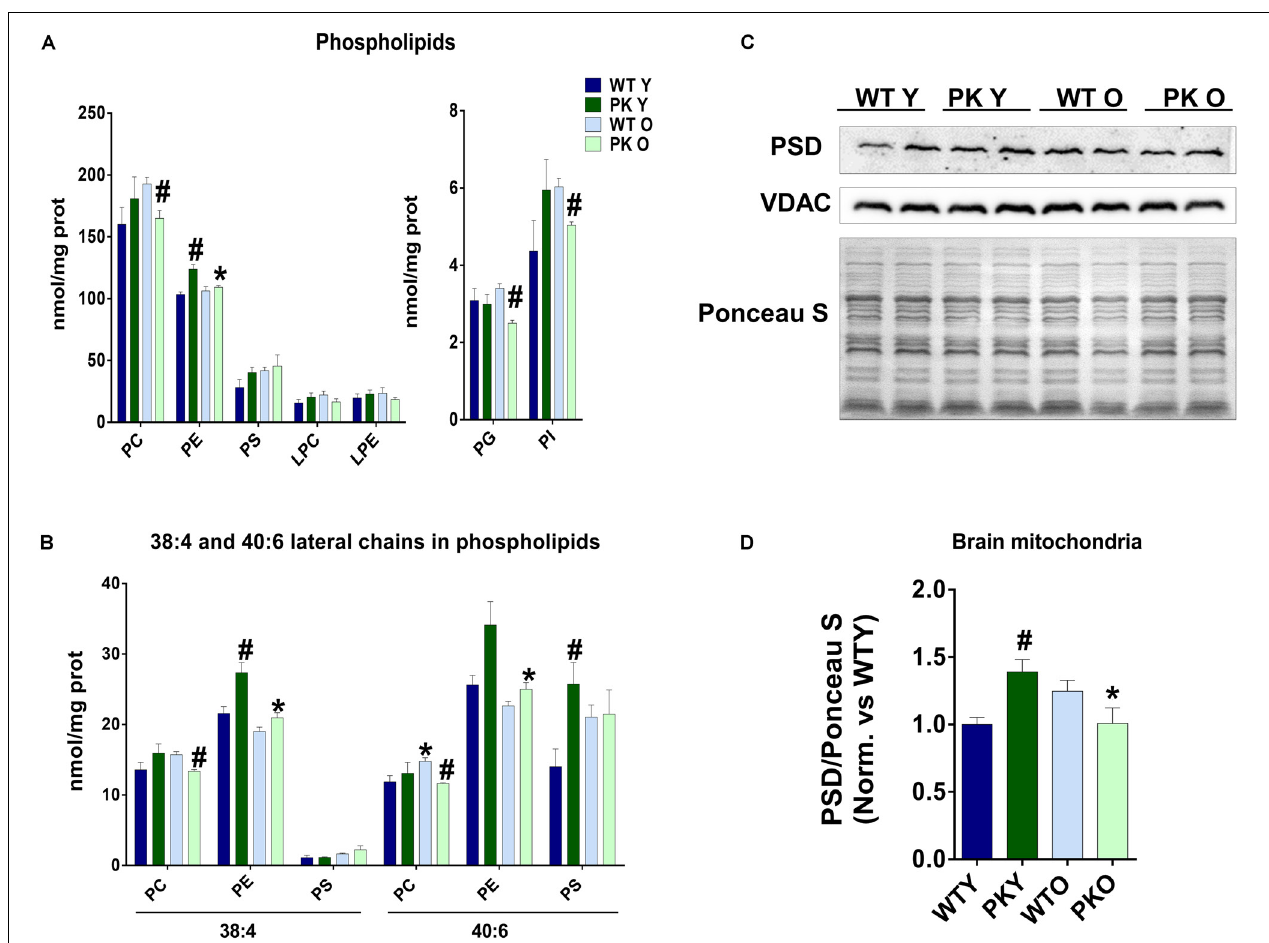
FIGURE 2 | PE levels change in PK-KO mice’s mitochondria due to PSD. (A) Levels of phospholipids (PC, PE, PS, LPC, LPE, PG, and PI) and changes due to aging and parkin loss. (B) Levels of phospholipids (PC, PE, and PS) containing arachidonic (20:4) or docosahexaenoic acid (22:6) as lateral chains. (C) Western-blot experiment showing PSD levels in brain’s mitochondria from WT and PK-KO mice. (D) Quantification of PSD intensity in brain’s mitochondria. Graphs represent the mean ± SEM. One Way ANOVA statistical analysis was performed. ∗ p < 0.05 due to aging. # p < 0.05 due to parkin loss. n = 4 for lipidomic analysis and n = 6 for western-blot